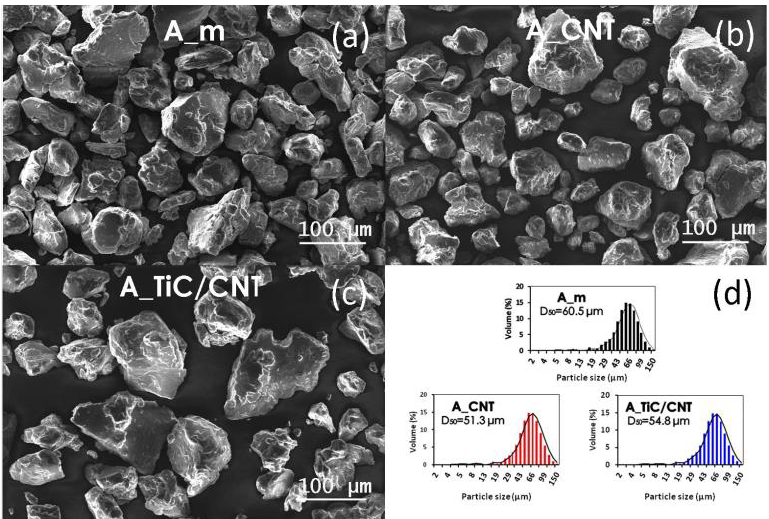
Figure 2. SEM images of matrix alloy powders after HEBM ( a ), CNT-reinforced composite ( b ) and TiC/CNT-reinforced composite ( c ), and particle size analysis of these powders ( d ). The XRD results of the powder materials and bulk samples are shown in Figure 3. The data obtained for the powder and bulk samples are qualitatively similar. They clearly show (111), (200), (220), (311) and (222) aluminum peaks. At the same time, no diffraction peaks of the reinforcing phases were observed. In general, this is typical for aluminum alloys re- inforced with carbon nanostructures even at higher concentrations of reinforcing